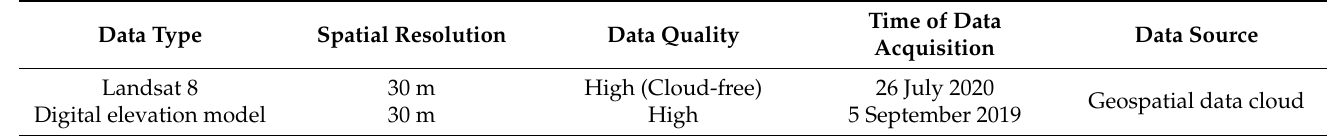
Table 1. Basic information on remote sensing